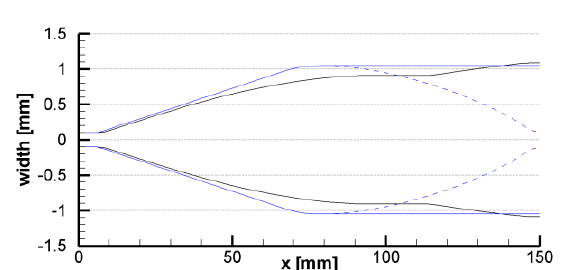
Fig. 4. Shape of manufactured slot (black) determined by the first method, another shape calculated by the second method (blue dashed) and with modified opening (blue solid).